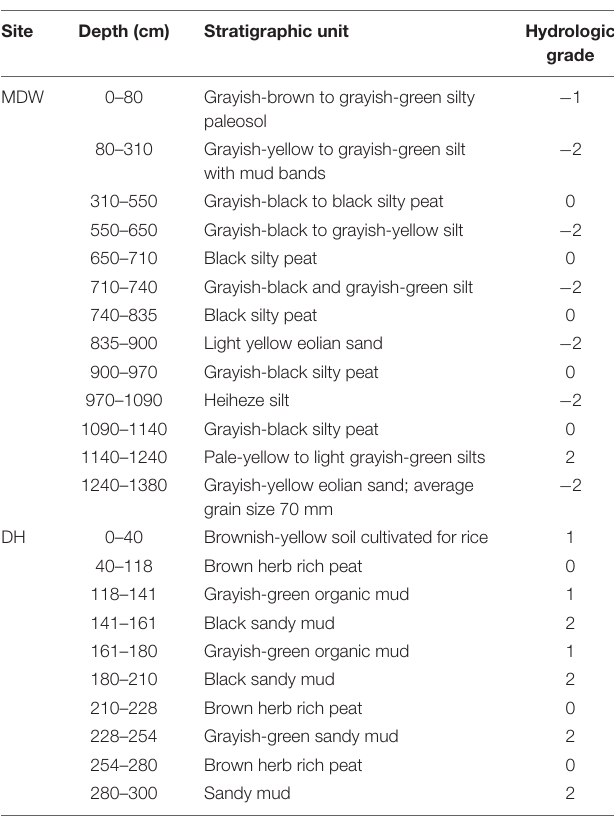
TABLE 2 | Stratigraphic description and hydrologic reconstruction at the Midiwan site (MDW) (see Zhou et al., 1996 for more details) and the Dahu site (DH) (see Zhou et al., 2004 for more details).